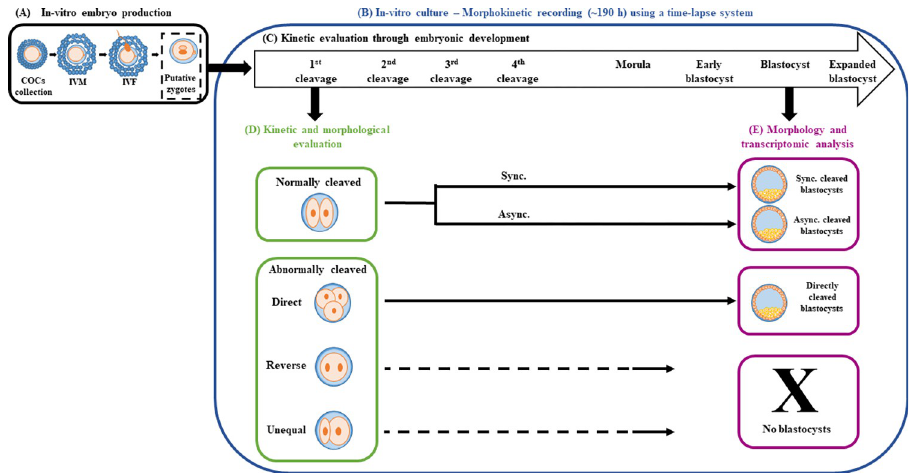
Fig 1. Experimental design. (A) Cumulus-oocyte complexes (COCs) were aspirated from bovine ovaries collected at the slaughterhouse and were in-vitro matured (IVM) and in-vitro fertilized (IVF). (B) Putative zygotes were individually cultured for 190 h in an incubator equipped with a time-lapse system to allow non-invasive, continuous monitoring of morphokinetic patterns throughout embryonic development. (C) Kinetics evaluation considered: (1) the timing of the 1 st , 2 nd , 3 rd , and 4 th cleavages, morula formation, blastulation, blastocyst and expanded blastocyst formation and (2) the characterization of the cleavage pattern into synchronous (sync.; corresponding to cleavages to 4-, 8-, and 16-cell stage embryos) and asynchronous (async.; corresponding to cleavages to 3-, 5-, 6-, 7-, 10-, and 12-cell stage embryos). (D) Kinetics and morphological evaluation of embryos from the 1 st cleavage; characterization of normal or abnormal (direct, unequal, and reverse) cleavages and their morphological distribution into good, fair, and poor. (E) Morphology and transcriptomic evaluation of the developed blastocysts; blastocysts that developed from synchronously, asynchronously, and directly cleaved embryos were morphologically evaluated as good, fair, or poor. No blastocyst development was recorded for the unequally or reverse-cleaved embryos. Samples of 4 blastocysts from each of the three cleavage categories (synchronous, asynchronous, and direct) were subjected to RNA extraction, followed by microarray analysis, and samples of 3 blastocysts from each group were validated by RT-qPCR (4 replicates). Fig 1 was created by Shira Yaacobi-Artzi with Microsoft PowerPoint